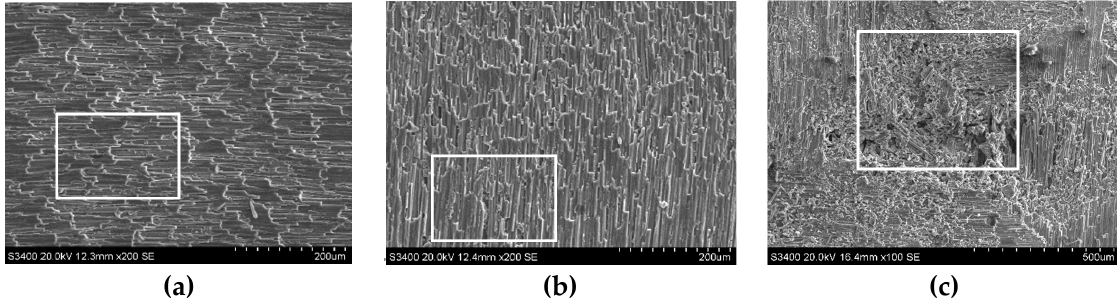
Figure 9. Surface damage types of the C/SiC composite after side face grinding. ( a ) 90° fiber step brittle fracture. ( b ) 0° fiber step brittle fracture. ( c ) Pores.